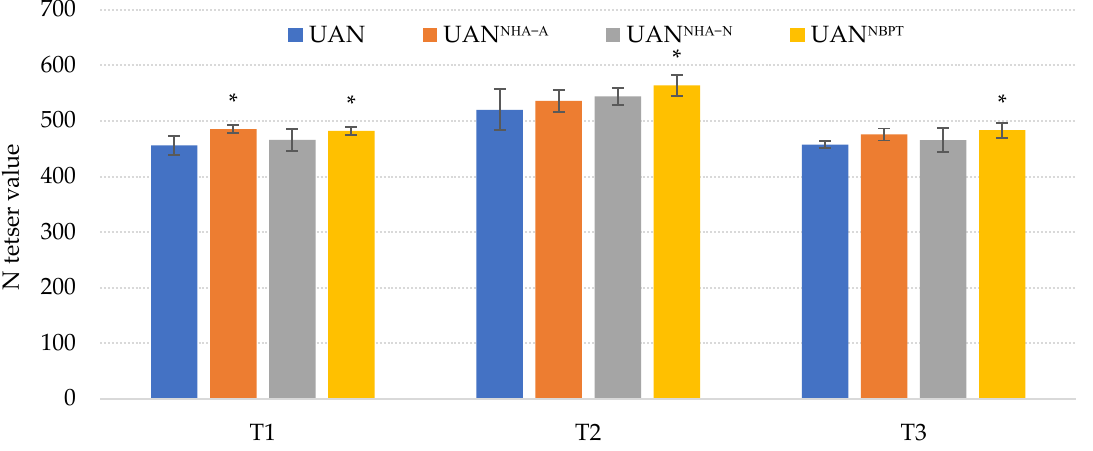
Figure 2. The effect of the UAN fertilizer with NHAs and NBPT on chlorophyll contents (N-tester value). The columns represent the mean ( n = 12); error bars present the mean standard deviation. The mean values marked with asterisk are significantly different ( p ≤ 0.05) from the treatment UAN by Tukey’s test (each of the terms was statistically evaluated separately).